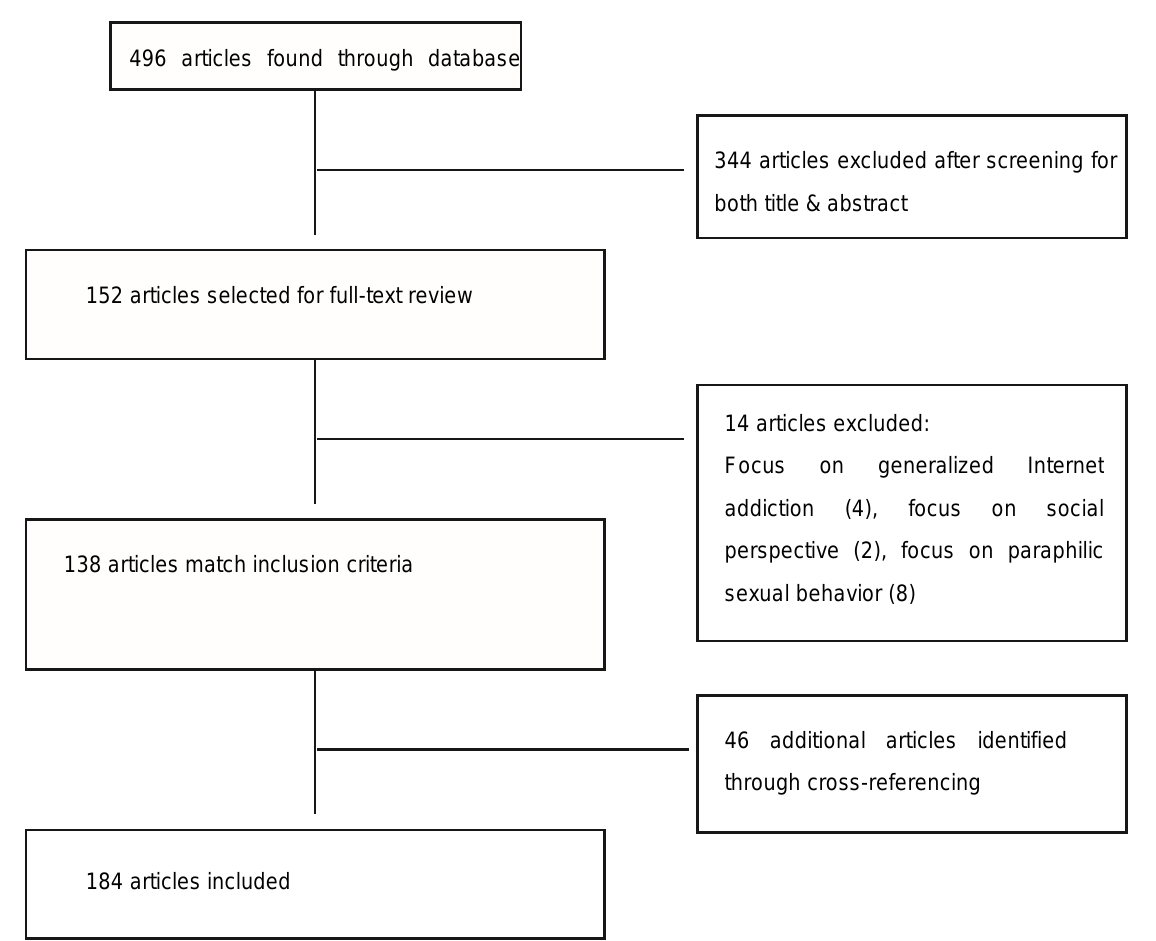
Figure 1. PRISMA flow diagram.